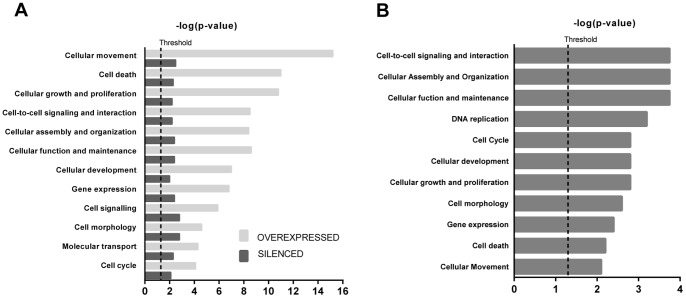
Most significantly altered cellular and molecular functions revealed by Ingenuity Pathway Analysis (IPA).(A) Functions significantly associated to syndecan-1 overexpression or silencing. Light gray bars show the gene set for syndecan-1 overexpression, dark gray bars show the gene set for syndecan-1 silencing. (B) Functions altered concomitantly by both overexpression and silencing. Molecules from both datasets that met the FC≥1.5 or FC≤−1.5 and q≤0.05 cutoff criteria were considered for the analysis. Right-tailed Fisher’s exact test was used to calculate a p-value. Bars represent the logarithmic values of the significance level (p), the dashed line corresponds to the threshold of p = 0.05.